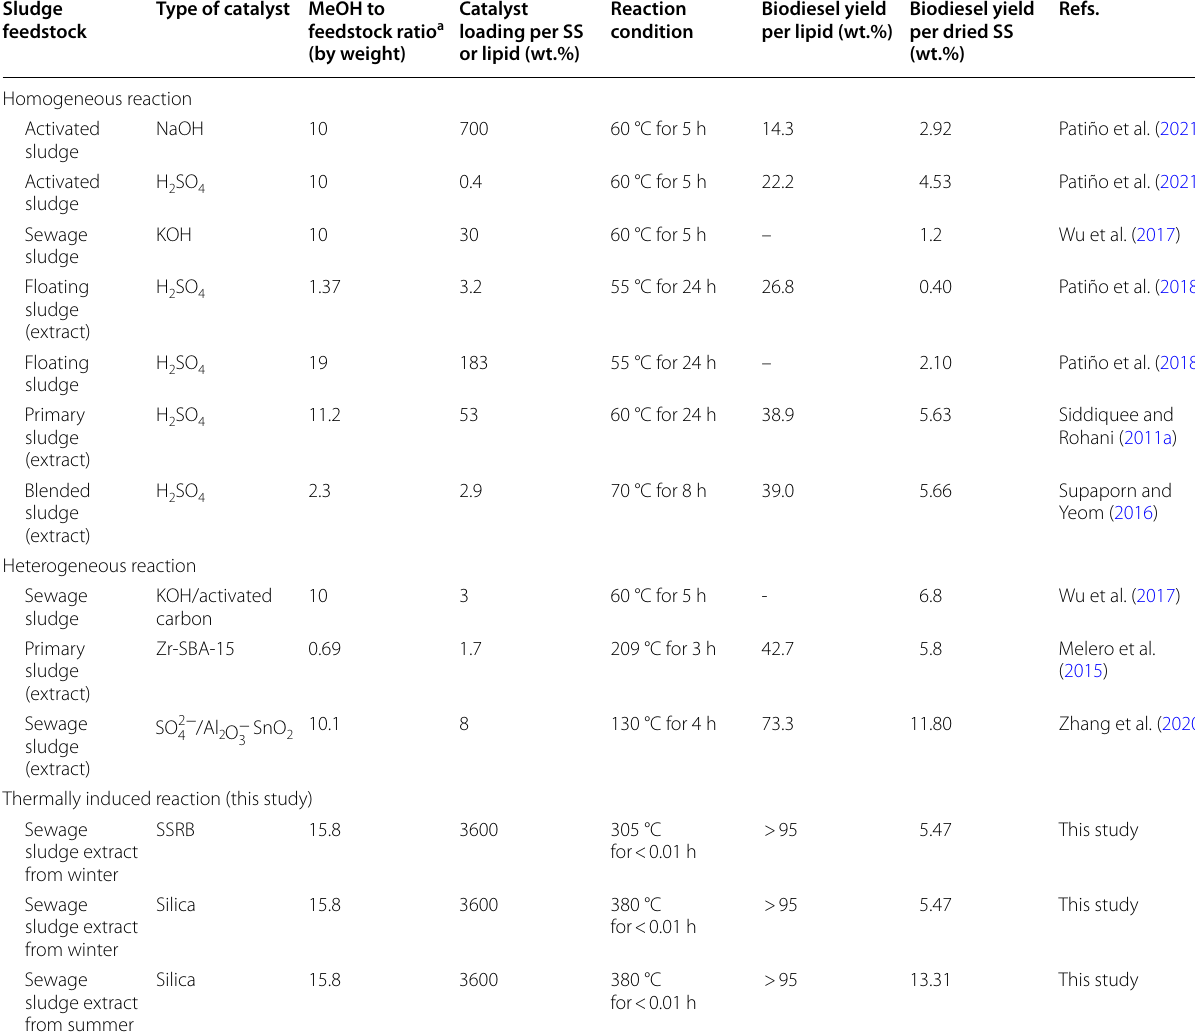
a The density of MeOH was assumed to be 0.792 g mL − 1